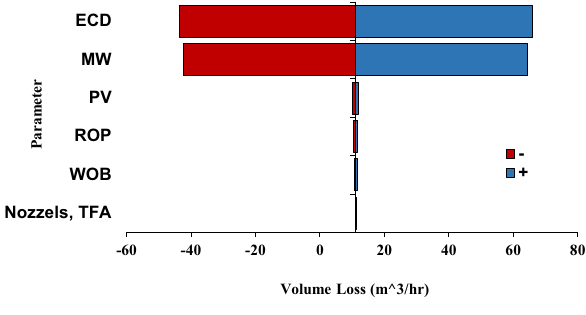
Fig. 10 Correlation loading plot of volume loss model